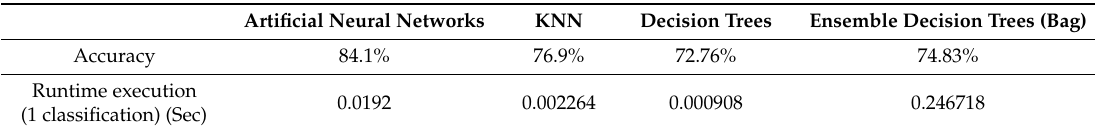
Table 5. Results Comparison (Testing data).